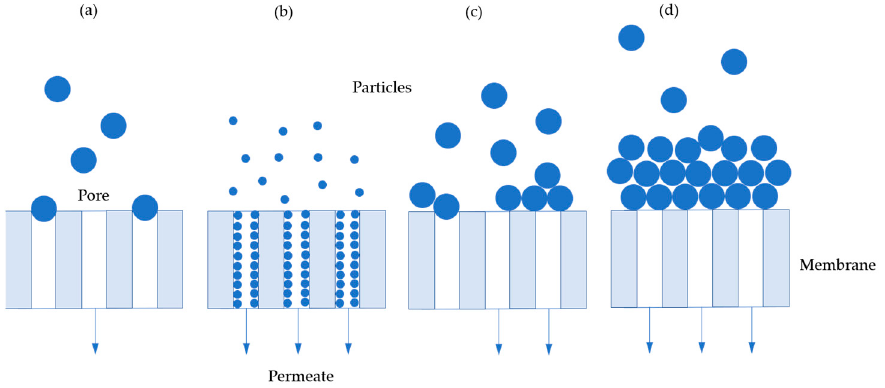
Figure 5. Common blocking mechanisms for dead-end filtration: ( a ) complete blocking, ( b ) standard blocking, ( c ) intermediate blocking, ( d ) cake filtration.